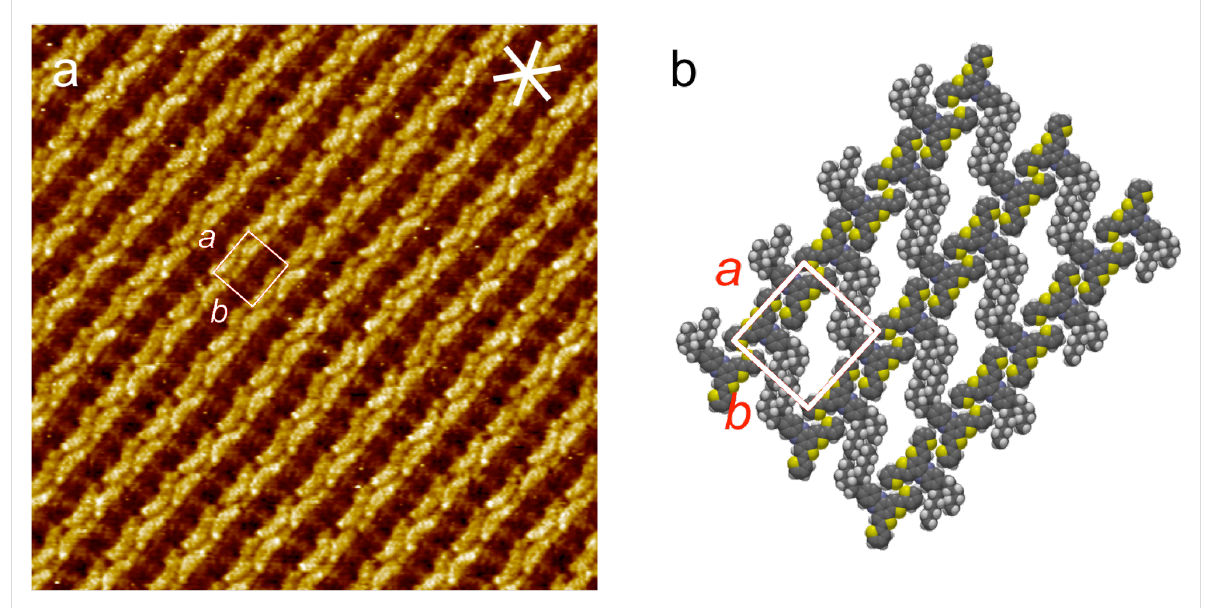
Figure 3: Self-assembled monolayer of 12b on HOPG. a) STM image ( V S = − 0.8 V, I t = 80 pA, image size 25.0 × 25.0 nm 2 ); b) structure model